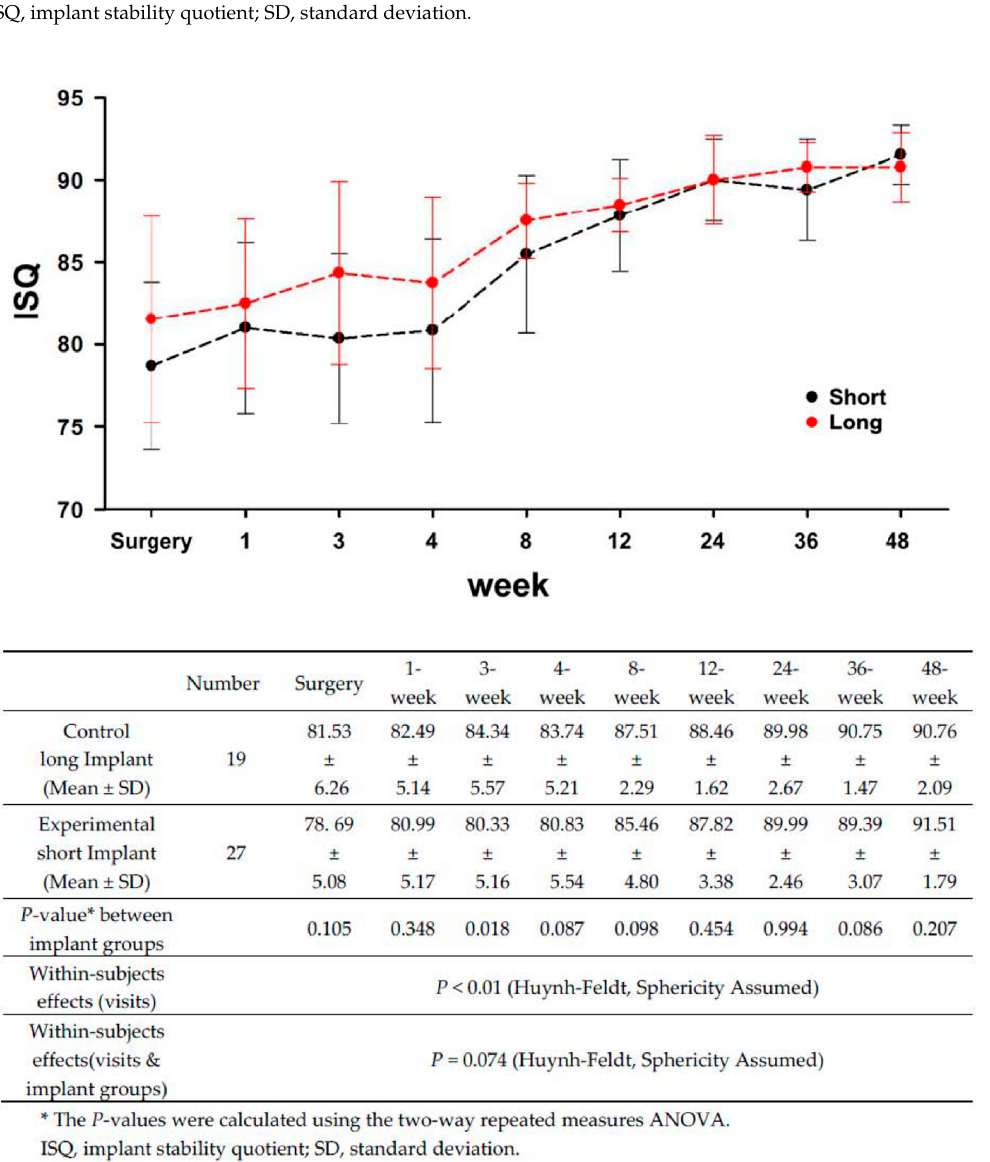
Table 2. Comparison of primary stability between the long and short implants.